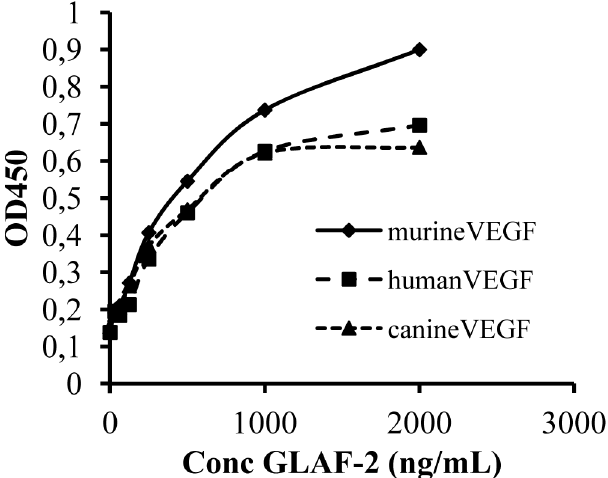
Figure 5. Interactions of purified GLAF-2 antibodies with canine, murine, and human VEGFs. Affinity and cross reactivity of GLAF-2 was demonstrated by ELISA. Equal concentrations of canine, murine, or human VEGF (100 ng/well) were coated on ELISA plates. Seven two-fold dilutions of purified GLAF-2 proteins ranging from 2000 ng/mL to 31.3 ng/mL were incubated with canine, murine and human VEGFs. PBS was used as negative control. For further ELISA experimental conditions see material and methods.